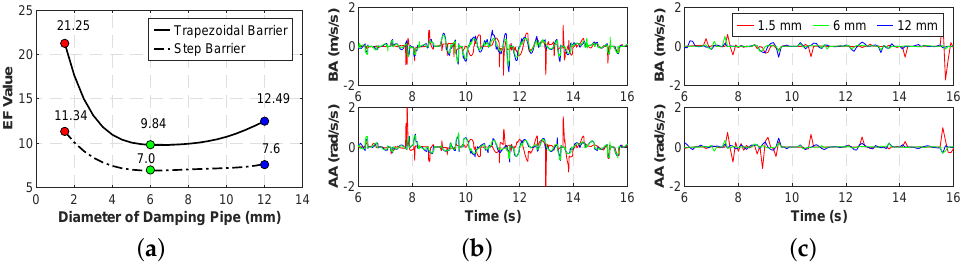
Figure 12. Performance comparison of different pipe diameters: ( a ) EF value ( b ) Acceleration values of trapezoidal barrier traversing ( c ) Acceleration values of step barrier traversing.